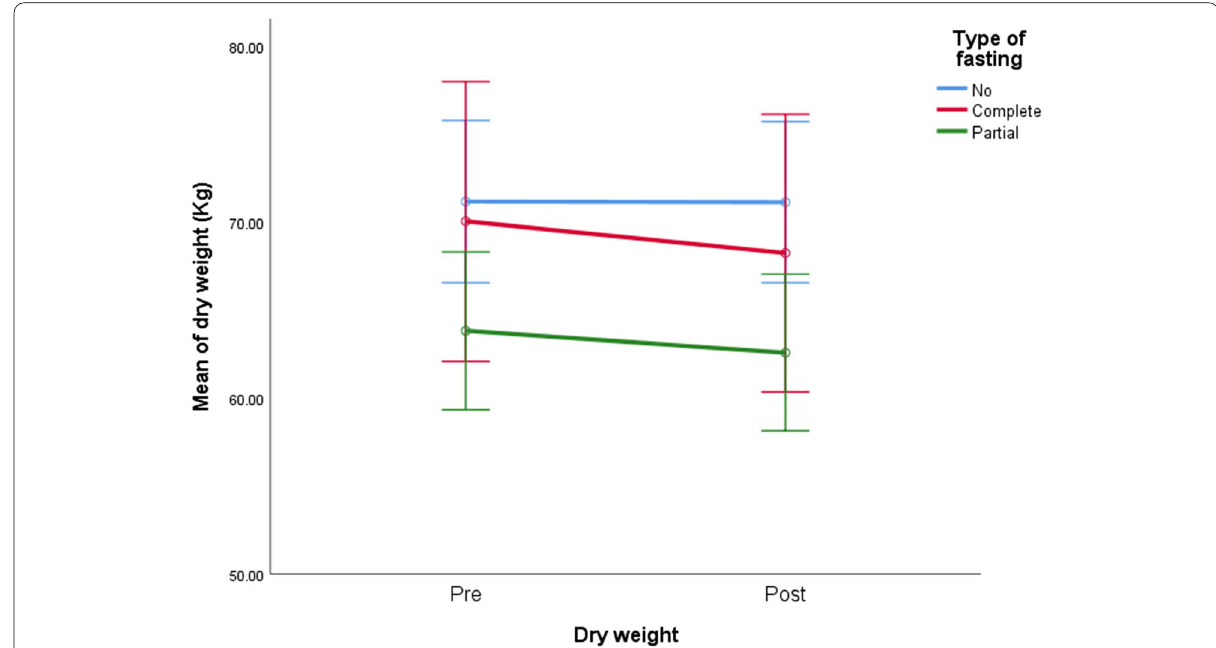
Fig. 1 Weight changes in different fasting groups of study population pre- and post-fasting